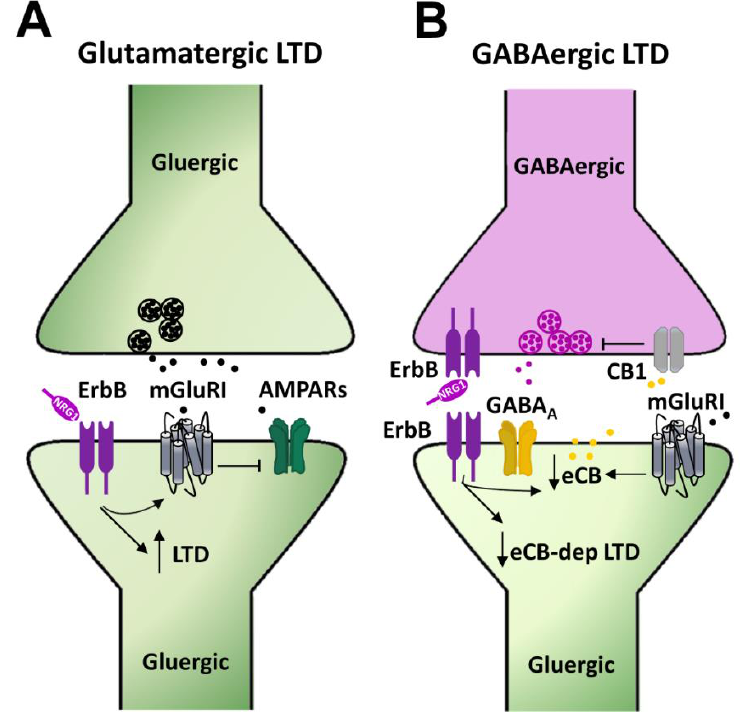
Figure 4. Mechanisms underlying NRGs / ErbB-dependent regulation of mGluRI-LTD in the hippocampus. ( A ) NRG1-dependent activation of ErbB receptors in CA1 pyramidal neurons, by regulating mGluRI function, controls the LTD magnitude of AMPAR-mediated transmission. ( B ) NRG1, by activating ErbB receptors, reduces endocannabinoids (eCBs) levels, thus impairing the eCB-dependent LTD of GABAergic transmission, which is physiologically triggered by the eCB-mediated activation of CB1 located on presynaptic GABAergic terminals, controlling GABA release.